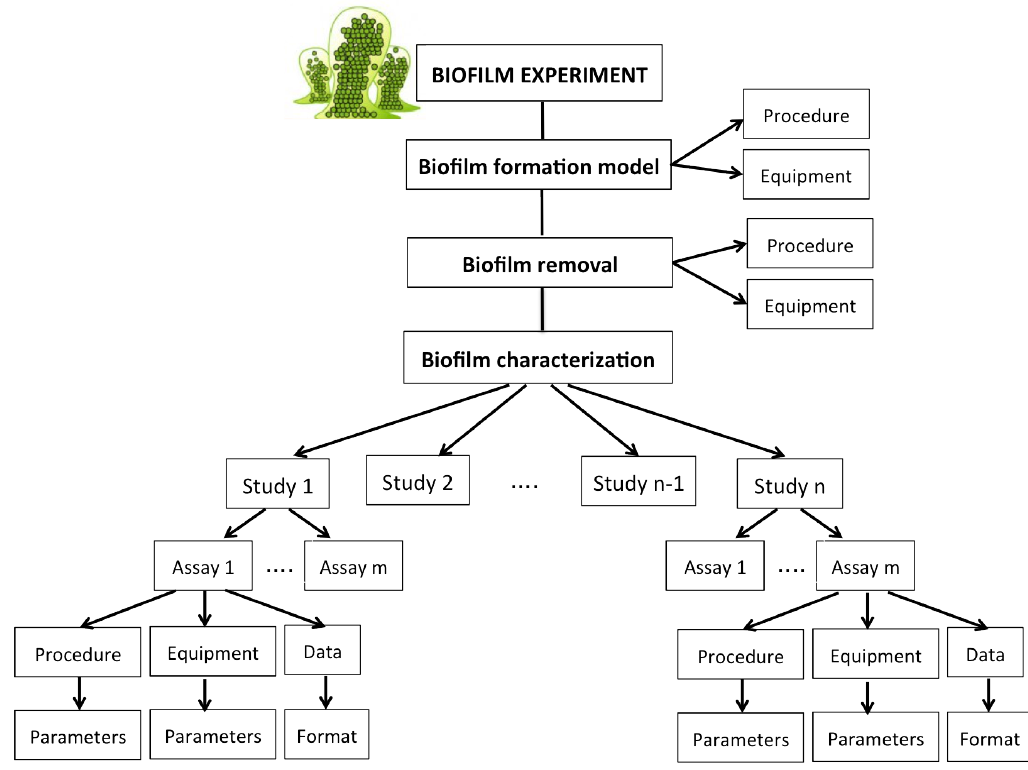
Figure 1: A general and abstract view of a biofilm study. A biofilm study consists of a number of different disciplinary studies, e.g. microscopy, proteomics, metabolomics, and transcriptomics analyses. Those studies can involve numerous assays and each assay is composed by an experimen- tal procedure, with a set of parameters, equipment, which also have parameters, and generates data in particular format according the kind of assay